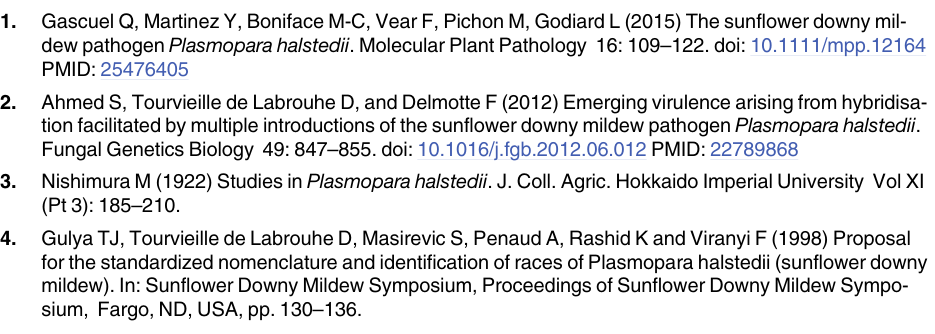
S1 Table. Description of the 54 putative effectors identified in Pl . halstedii and their poly- morphisms. The table lists EST names of effectors and their corresponding PSI-tBLASTn best values against an oomycete effector gene database generated from Genebank, the effector names and their conserved motifs, and eventual signal peptide predictions. For each effector candidate, a multifasta file combined with an alignment of the effector genomic sequences in seven pathotypes (PLHAL ” pathotype_name ” xxxx) and the EST used as query (Plhalyyyyyy), are provided in column “ NA multifasta file ” . Corresponding translated sequences and align- ments are also provided (AA multifasta file and AA multifasta alignment). Hypothetical Pro- grammed Ribosomal Frameshifting (PRF) processes are indicated (see Discussion). The nucleic sequences showing identified SNPs are listed (see also S1 File) and indicated as KASP markers when used. S2 Table. Effector polymorphisms, PCR programs, and primers used for KASP markers. The position of the polymorphism relative to the start of the CDS is indicated in parentheses. Sequences of specific primers are respectively added at 5 ’ end by FAM tag ( GAAGGTGACCAAG TTCATGCT ) or VIC tag ( GAAGGTCGGAGTCAACGGATT